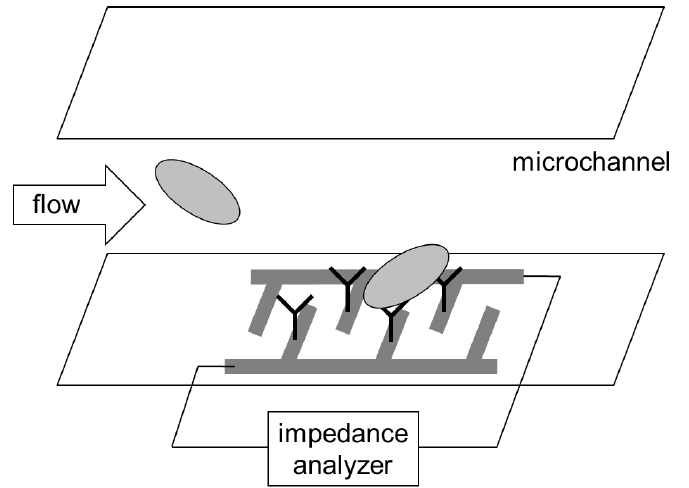
Figure 9. IME (interdigitated microelectrode) immunoassay